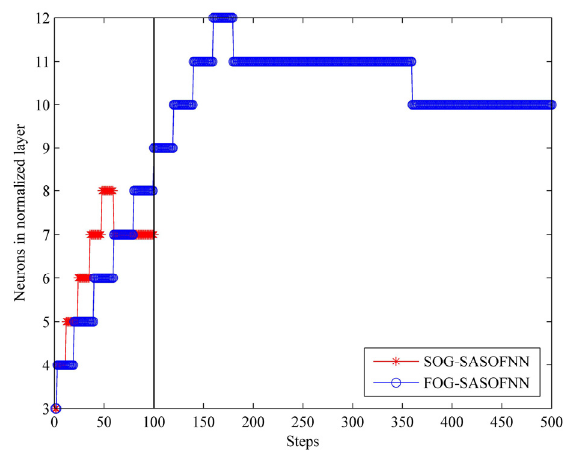
Figure 6. Dynamic structure process of SOG-SASOFNN and FOG-SASOFNN.